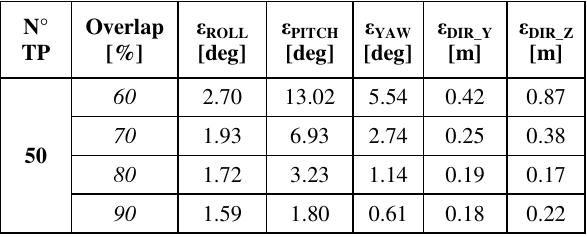
Table 5. Error propagated – 50 TP – simulation 2